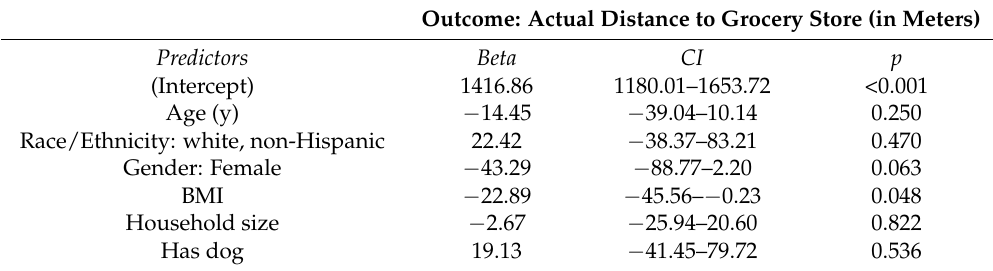
Table 2. Fully-adjusted mixed model with block group random effect: Individual and neighborhood correlates of actual distance to nearest grocery